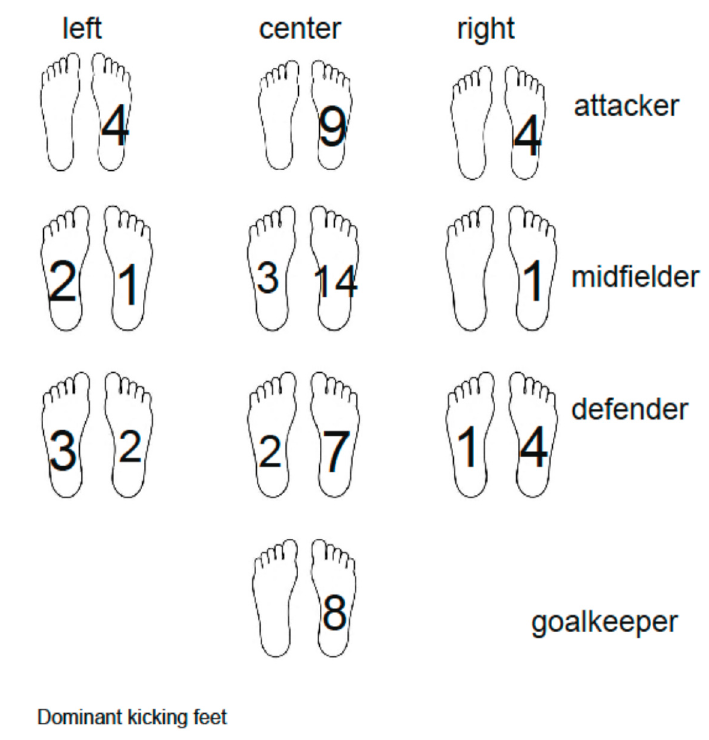
Figure 2. Dominant kicking leg—number of players by the position.